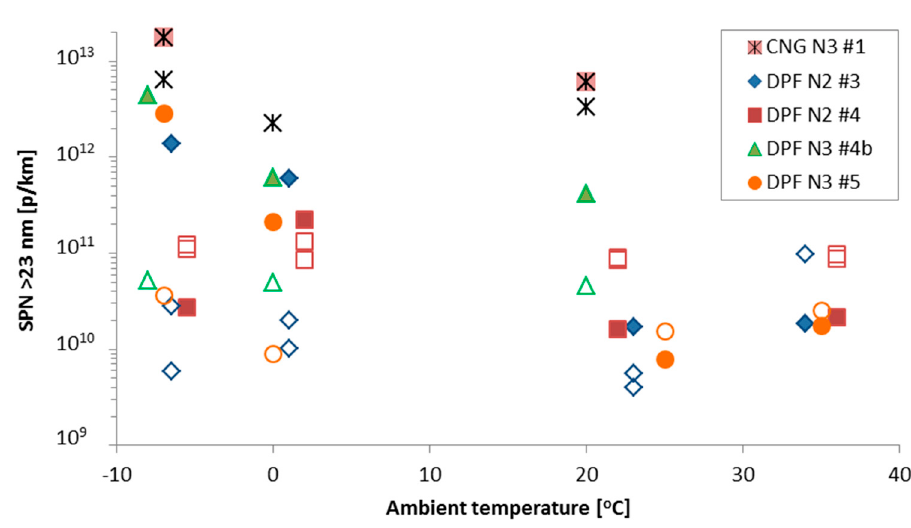
Figure 6. Urban phase with cold (solid symbols) or hot (open symbols) engine start at different ambient temperatures for different vehicles. Temperatures have been shifted ±1 °C for better visualization.